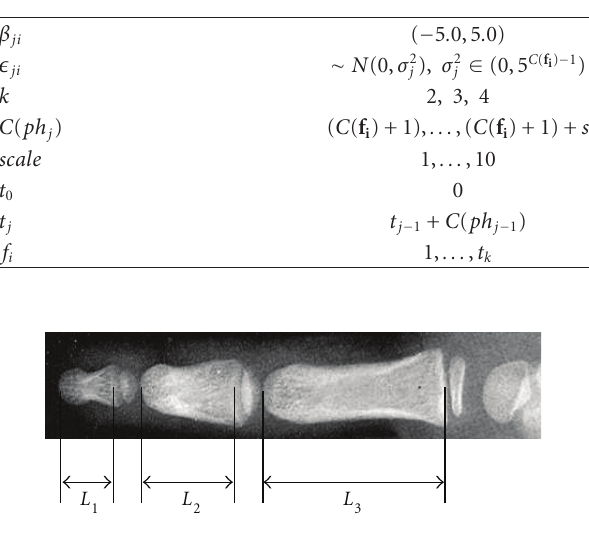
Figure 3: Illustration Of L 1 , L 2 and L 3